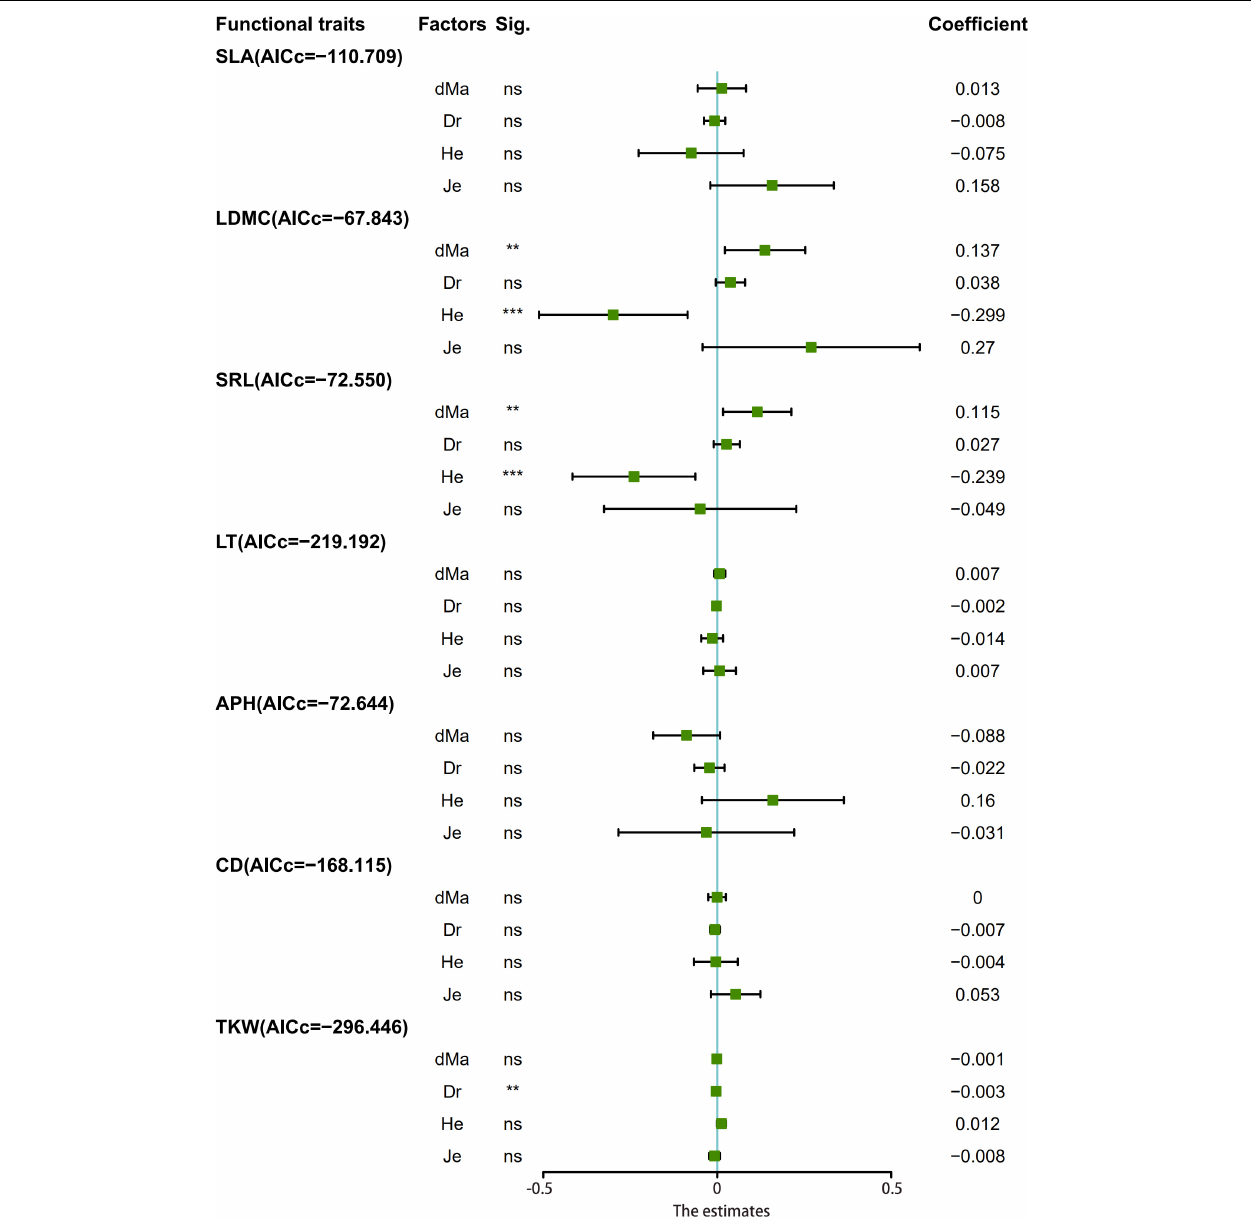
FIGURE 6 | Generalized linear mixed model (GLMM) model coefficient estimates and 95% confidence intervals showing the influence of the alpha diversity of communities on the herb functional traits on the landslides. SLA, specific leaf area; LDMC, leaf dry matter content; SRL, specific root length; LT, leaf thickness; APH, average plant height; CD, crown diameter; TKW, thousand kernel weight; Je, Pielou index; He, Shannon index; Dr, Simpson index; dMa, Margalef index; **, significant at the 0.05 level; ***, significant at the 0.01